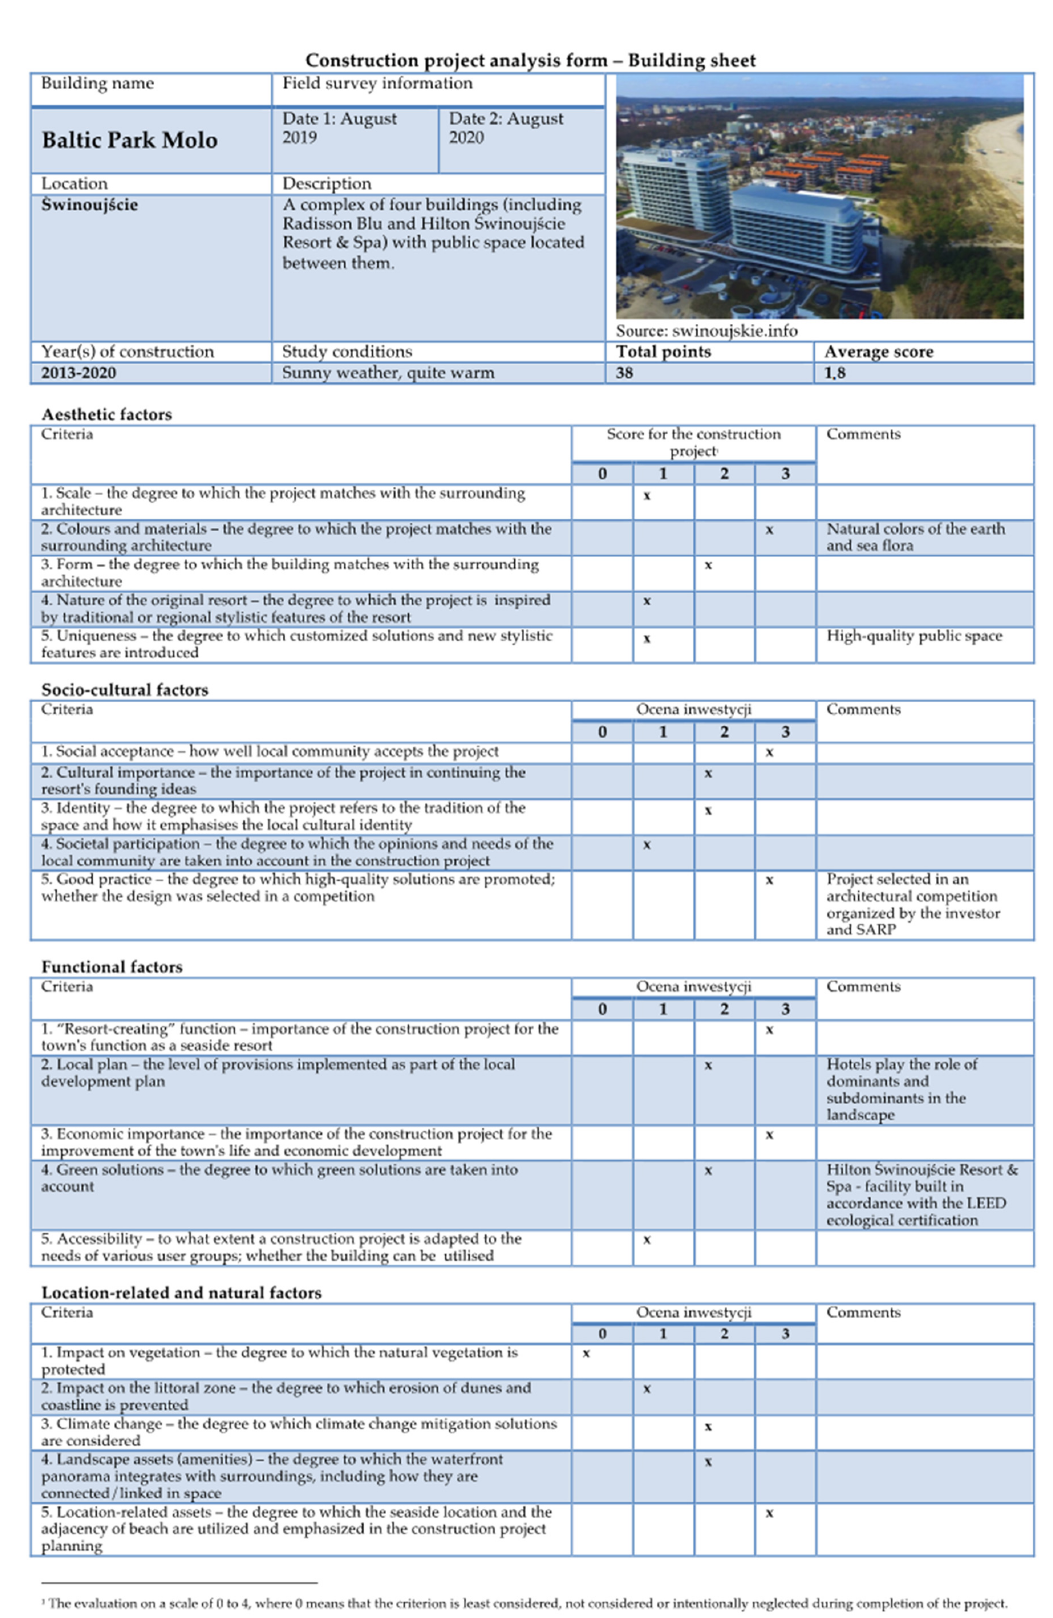
Figure A2. Baltic Park Molo in Ś winouj ś cie. Building sheet.